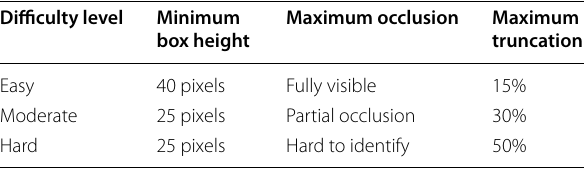
Table 2 Difficulty division of KITTI dataset